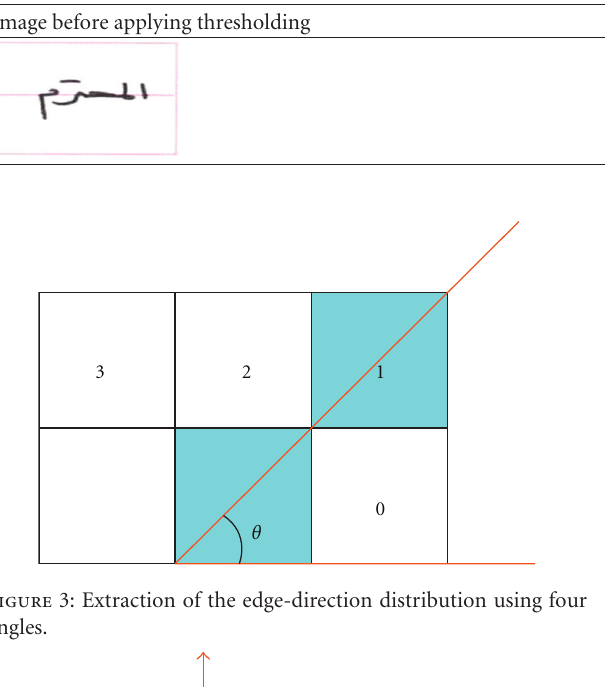
Table 2: Otsu’s thresholding for an image with pink border.